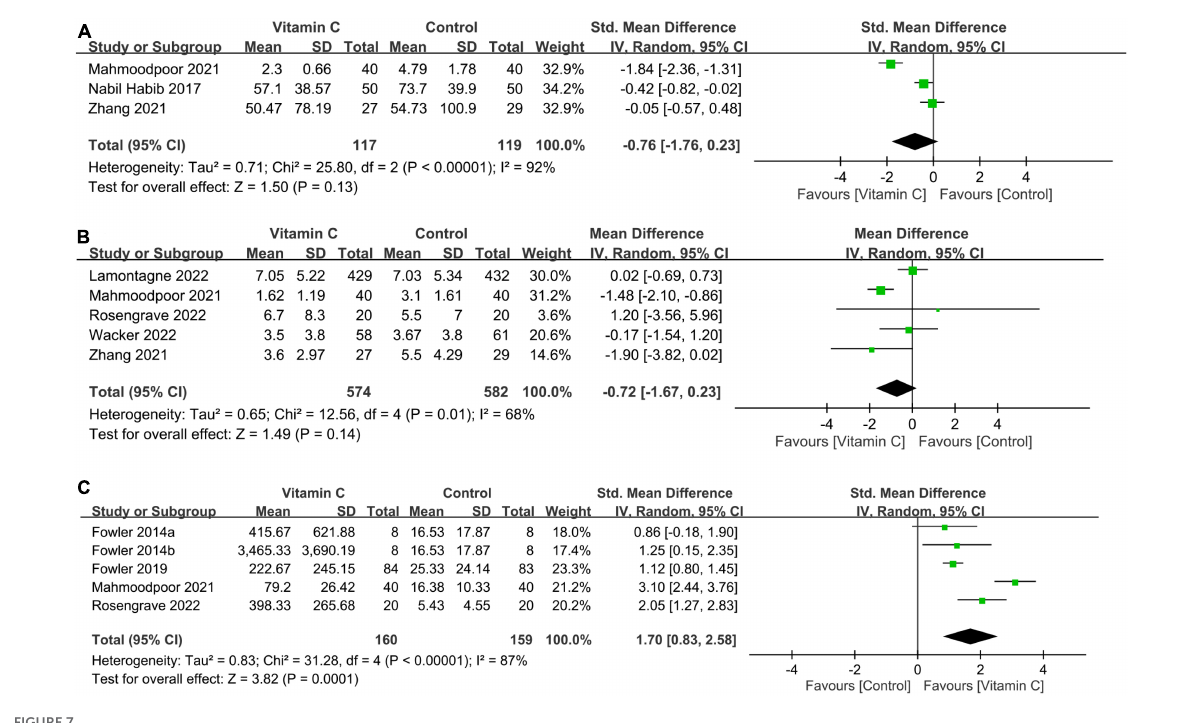
the control group based on a previous study (16) may bias our findings. Nevertheless, the heterogeneity was low in our mortality rate, indicating a low risk of bias. Second, the wide variation in vitamin C dosage and frequency across our included study not